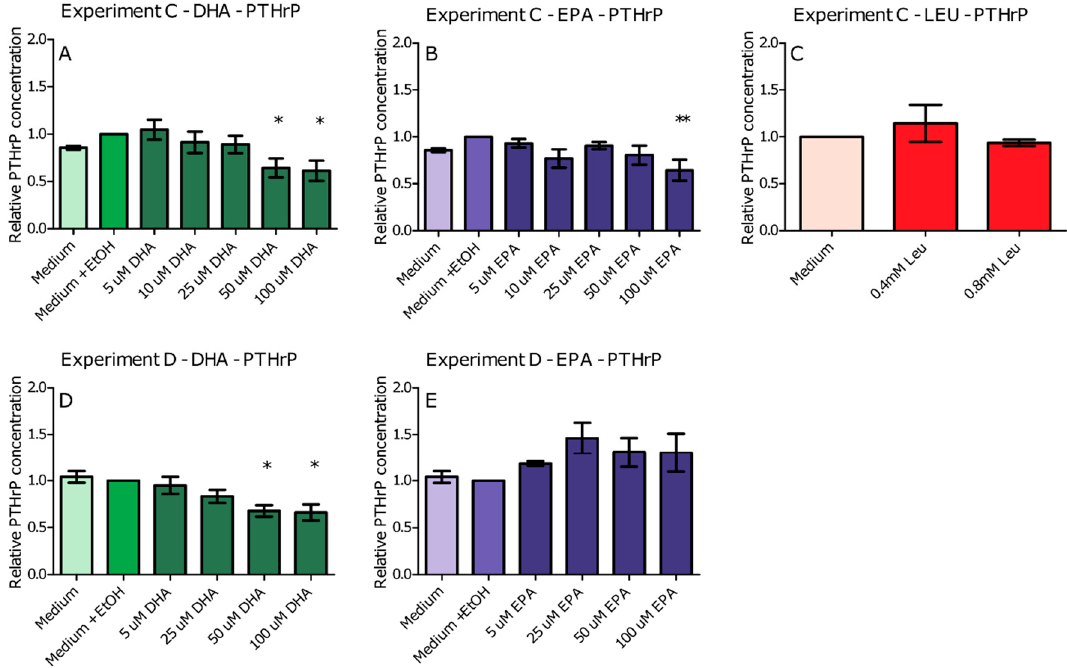
Figure 3. Effect of supplementation of C26 cells with docosahexaenoic acid (DHA) ( A , D ); eicosapentaenoic acid (EPA) ( B , E ); and leucine (LEU) ( C ) on PTHrP levels on low ( A – C ); and high ( D , E ) number of cells. Data represent mean ± SEM. *, ** and *** represent significant differences with vehicle control (respectively, p < 0.05, p < 0.01 and p < 0.001).